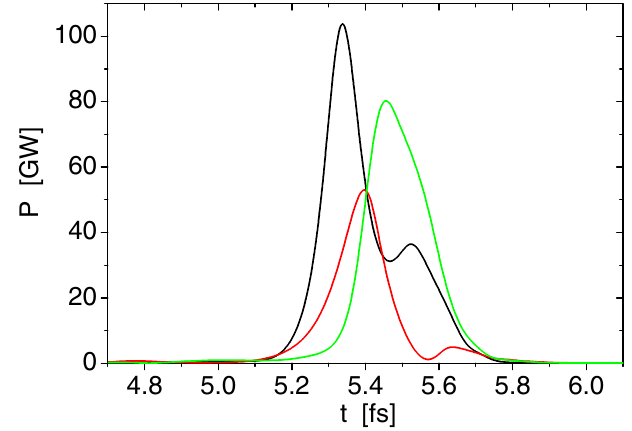
FIG. 7. (Color) Temporal structure of the radiation pulse (three different shots) at the undulator length 100